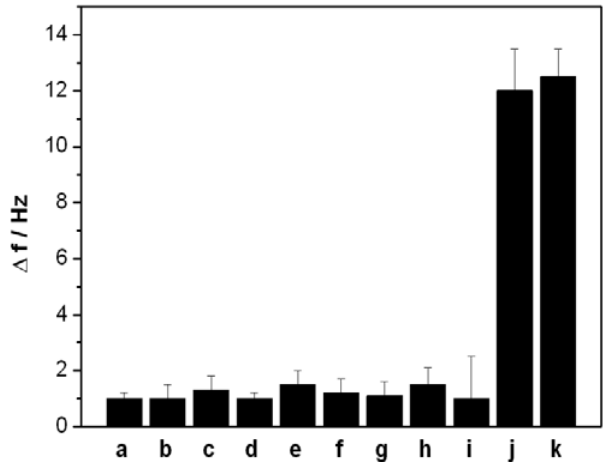
Figure 6. Response of the QCM-based sensor to different ions: ( a ) 0.5 mM Ca 2+ ; ( b ) 0.5 mM Mg 2+ ; ( c – h ) Cu 2+ , Cd 2+ , Pb 2+ , Zn 2+ , Ni 2+ , Ag + (0.5 µM, each); ( i ) Au 3+ (0.1 µM) ( j ) 5 nM Hg 2+ ; ( k ) the mixture of Ca 2+ , Mg 2+ (0.5 mM, each), Cu 2+ , Cd 2+ , Pb 2+ , Zn 2+ , Ni 2+ , Ag + (0.5 µM, each); and 5 nM Hg 2+ .